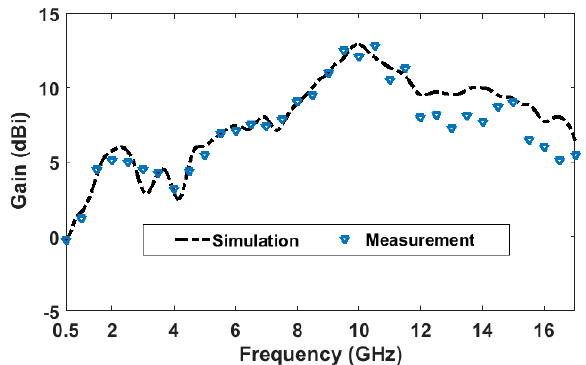
Figure 11. Gain of the proposed antenna.